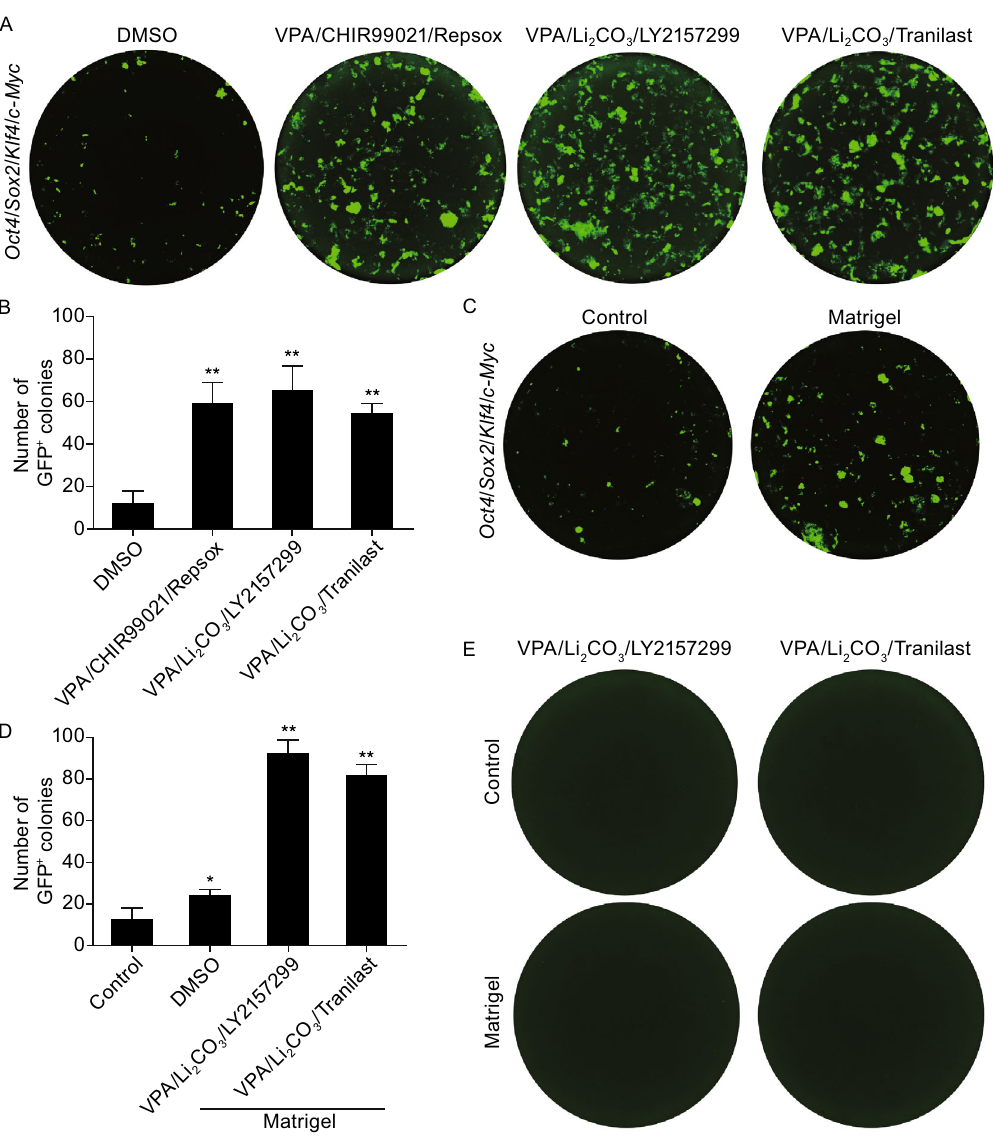
Figure 2. Combination of drugs promotes cell reprogramming in vitro . (A) Combination of chemical compounds or combination of drugs promotes GFP + pluripotent stem cell generation from Yamanaka factors-induced OG2-MEFs. Images were taken on day 10 post-infection. VPA, 0.5 mmol/L. CHIR99021, 3 μ mol/L. Repsox, 1 μ mol/L. Li 2 CO 3 , 0.3 mmol/L. LY2157299, 1 μ m/L. Tranilast, 30 μ mol/L. (B) Quanti fi cation of GFP + colonies in (A). (C) Generation of GFP + pluripotent stem cell from Yamanaka factors-induced OG2-MEFs with or without Matrigel. Images were taken on day 10 post-infection. (D) Quantify the GFP + colony numbers from Yamanaka factors-induced OG2-MEFs 10 days post-infection with diverse treatments. (E) No GFP + colonies was observed 28 days after OG2-MEFs treated with combination of drugs, without introduction of Yamanaka factors. All fi gures are representative of